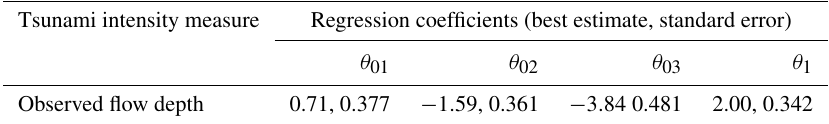
Table E3. Regression coefficients for the 2004 IOT in Khao Lak–Phuket (Thailand) based on